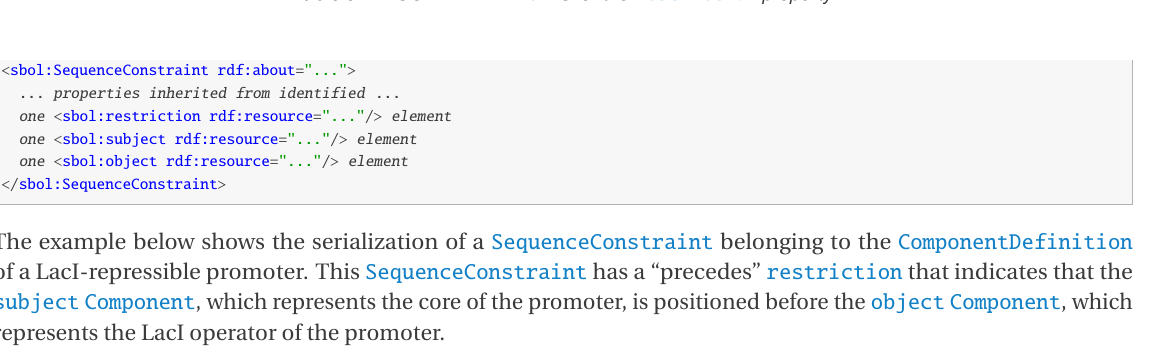
Table 9: RECOMMENDED URI s for the restriction property.